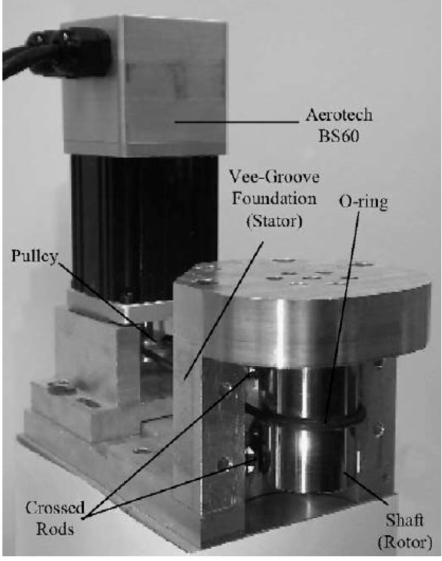
Figure 57. Photograph of a prototype of a kinematic spindle [20].